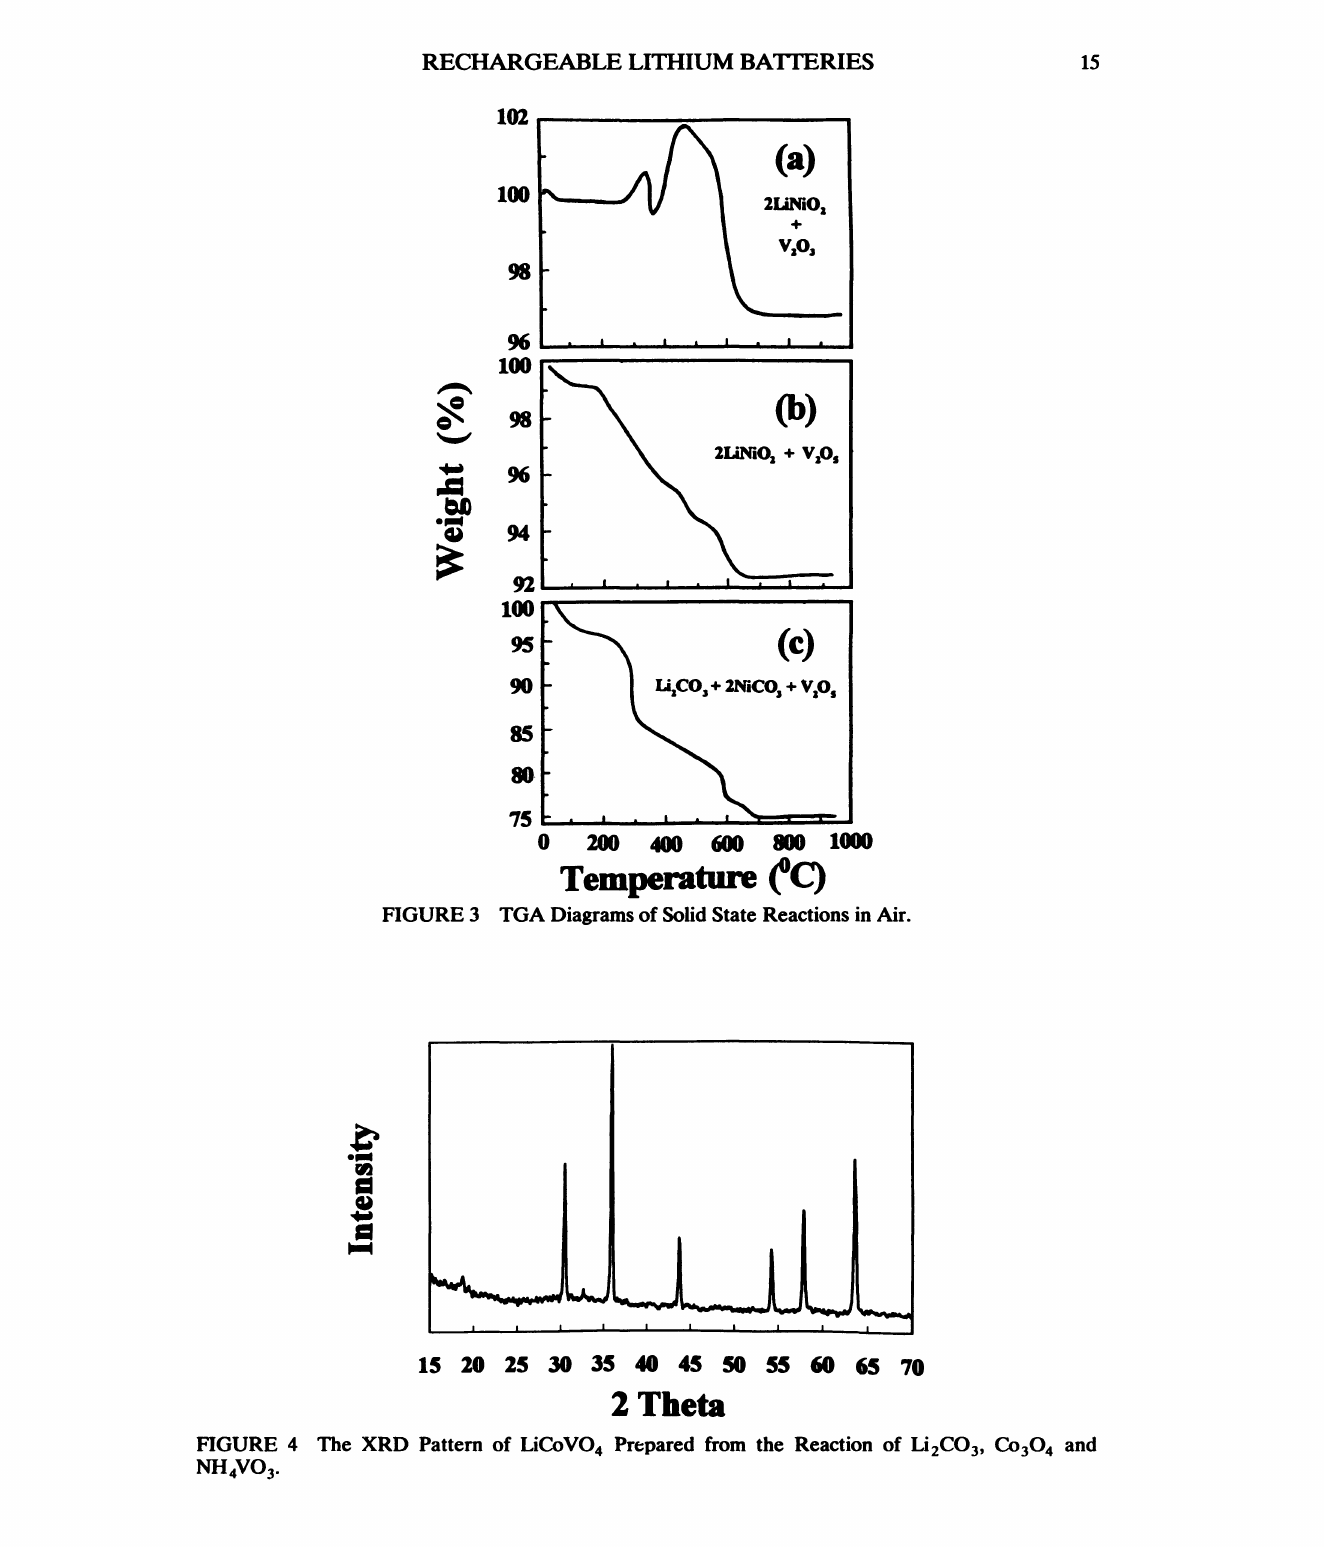
Prepared from the Reaction of LiCO3, 304 and 4